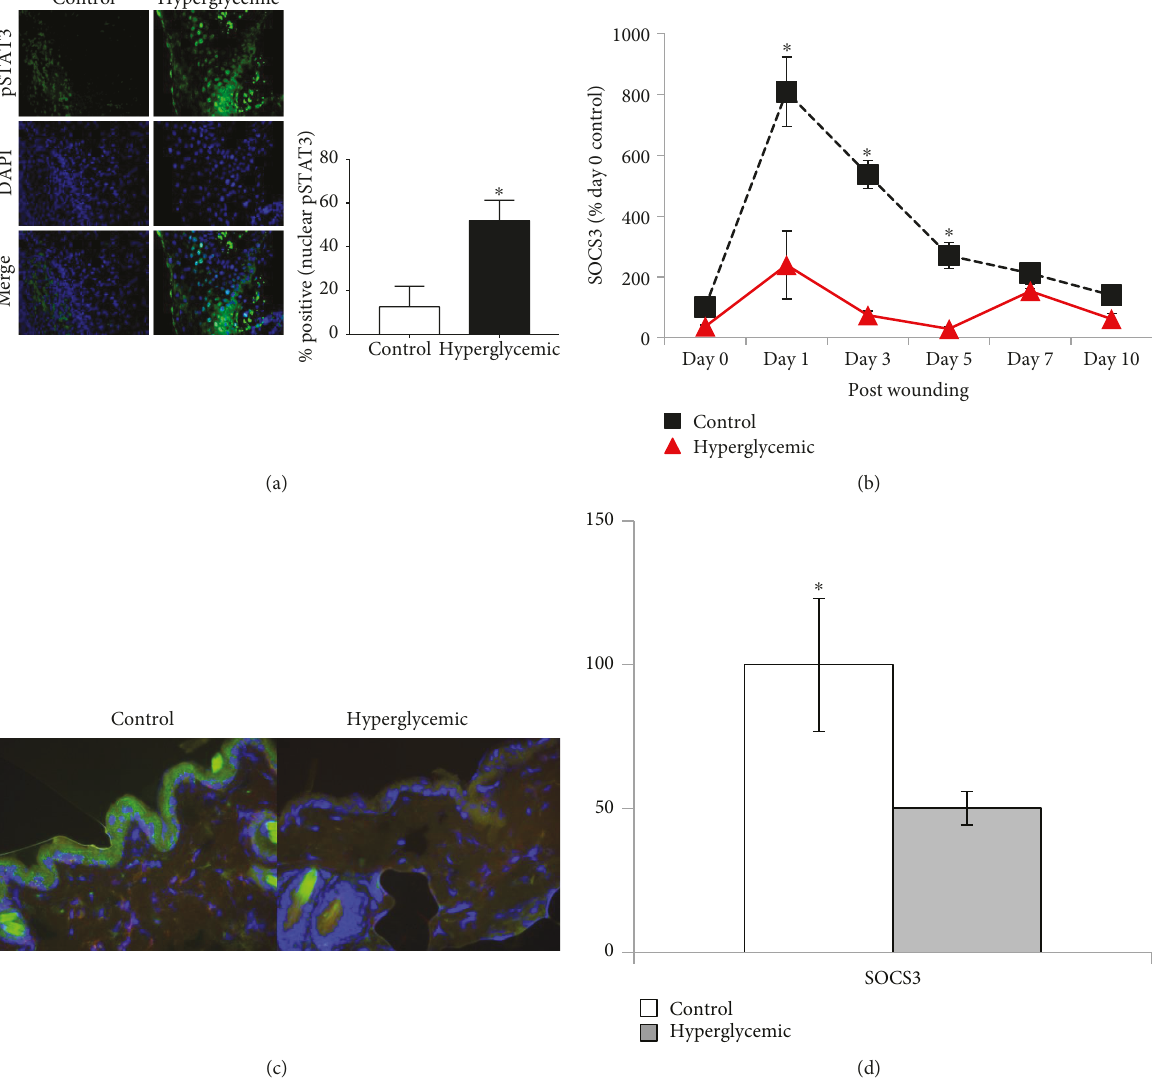
Figure 3: Hyperglycemia alters IL-6R signaling and function in the skin. Following four weeks of hyperglycemia, hyperglycemic and euglycemic control mice were wounded using a 4 mm biopsy. (a) Nuclear localization of pSTAT3 was determined in para ffi n-embedded wound tissue by image analysis of immunohistology utilizing ImageJ64 software (v1.47, https://imagej.nih.gov/ij). Images were obtained at 400x magni fi cation ( n = 3 ). (b) SOCS3 mRNA expression in wound tissue analyzed via RT-PCR, and expression was expressed as percent control (day 0 control animals, n = 10 ). (c) SOCS3 expression in the epidermis was assessed by immunohistological staining (green), at 400x magni fi cation, and (d) quantitated by ImageJ64 software as percent control value ( n = 10 ). Data are presented as the means ± SE ( ∗ p < 0 05 , signi fi cantly di ff